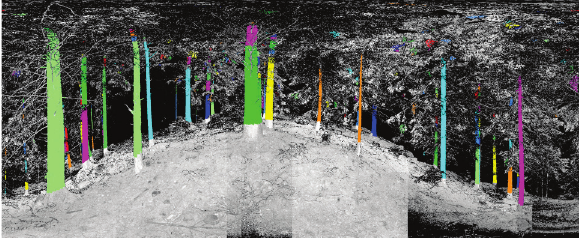
Figure 2. TLS survey and trees delineation using Treemetrics Autostem software